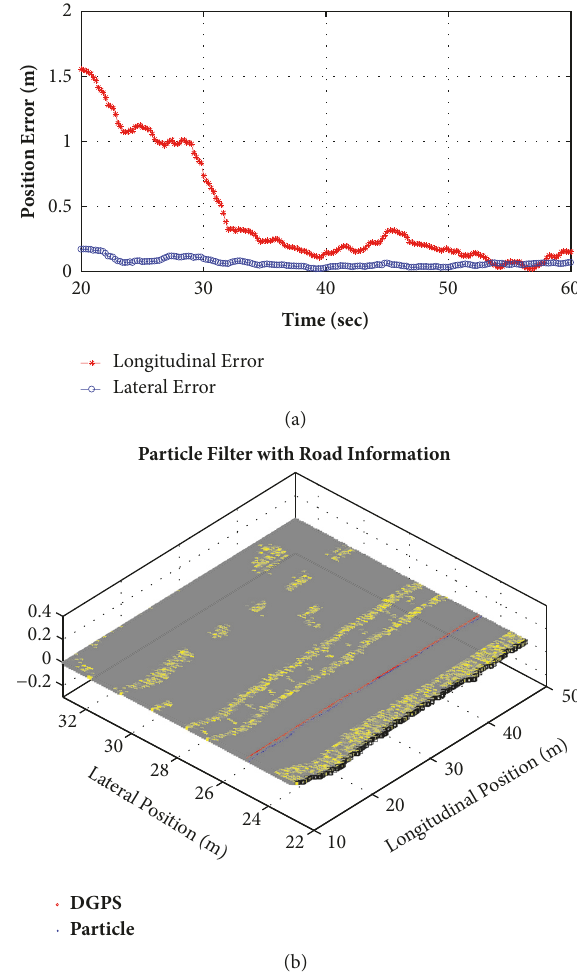
Figure 11: Particle filter localization at the first section (between 20 s and 60 s): (a) the position error and (b) the comparison of the trajectory obtained by the particle filter and the